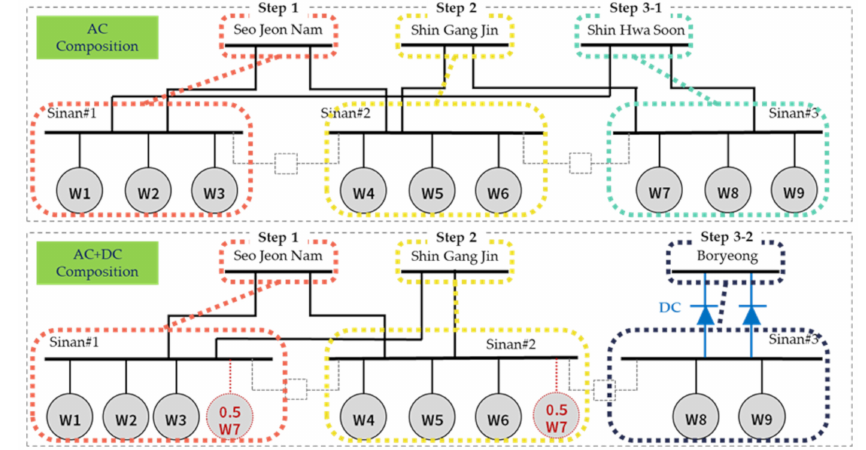
Figure 14. System diagram according to the connection